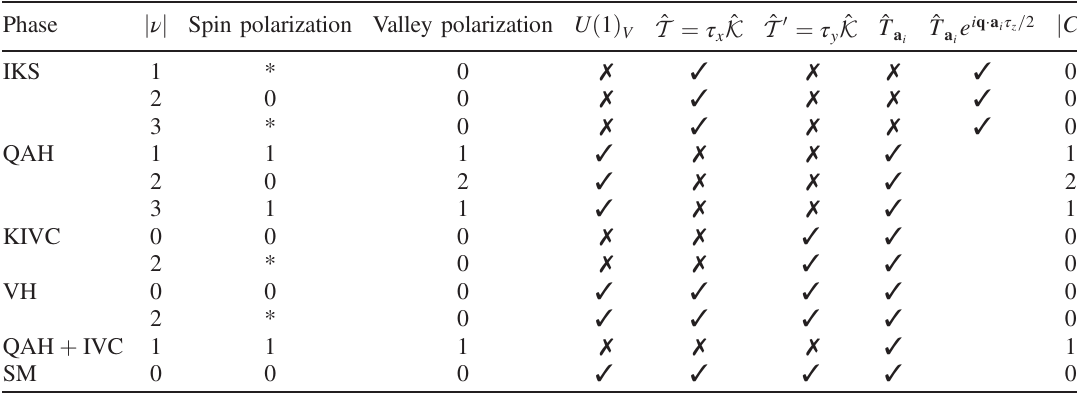
TABLE I. Symmetries and order parameters of HF phases at integer fillings ν . Spin (valley) polarization indicates the number imbalance of ↑ vs ↓ ( K vs K 0 ) electrons per moir´e unit cell. The spin quantization axis is arbitrary due to SU ð 2 Þ S symmetry, and an asterisk indicates a degenerate manifold obtained by performing a valley-dependent spin ˆ K rotation. τ μ are Pauli matrices in valley space, and is complex conjugation. IKS phases break a subset of moir´e ˆ T þ translation symmetry ˆ T e i q · a i τ z = 2 , where q is the IKS translations a i but preserve the combined valley-rotation a i wave